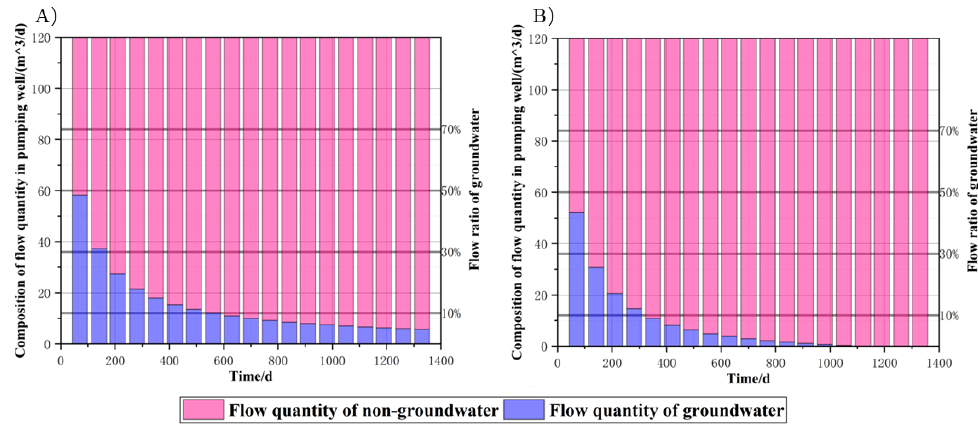
Figure 10. The bar graph of the composition of flow quantity in the pumping well at the whole C1 and C2 mining areas with the change in time (based on the average concentration from all pumping wells). Note: ( A ) ‐ Plan A; ( B ) ‐ Plan C. Table 2. Comparison of the day for plan A and plan C to reach the corresponding “flow ratio of groundwater”.